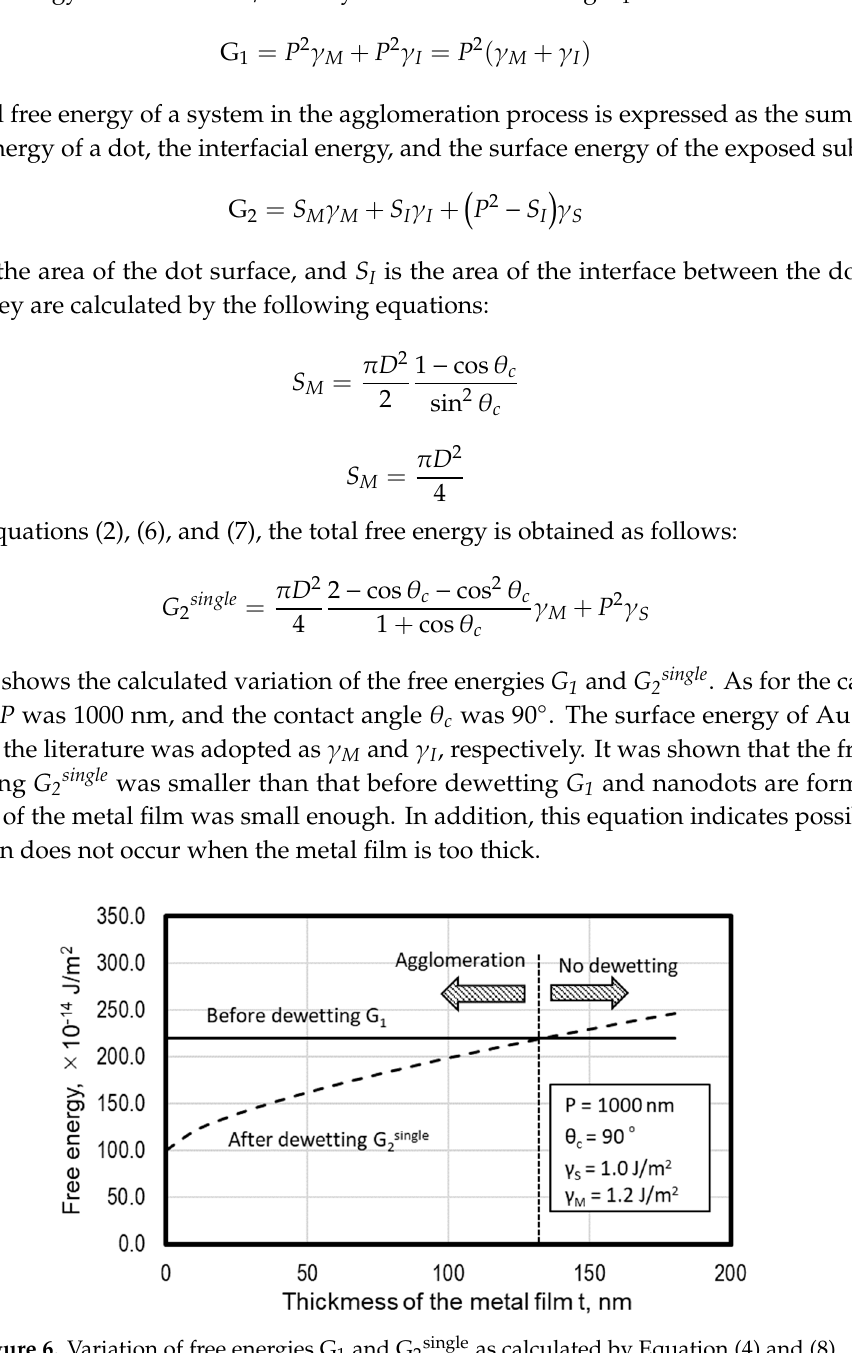
Figure 6. Variation of free energies G 1 and G 2single as calculated by Equation (4) and (8).